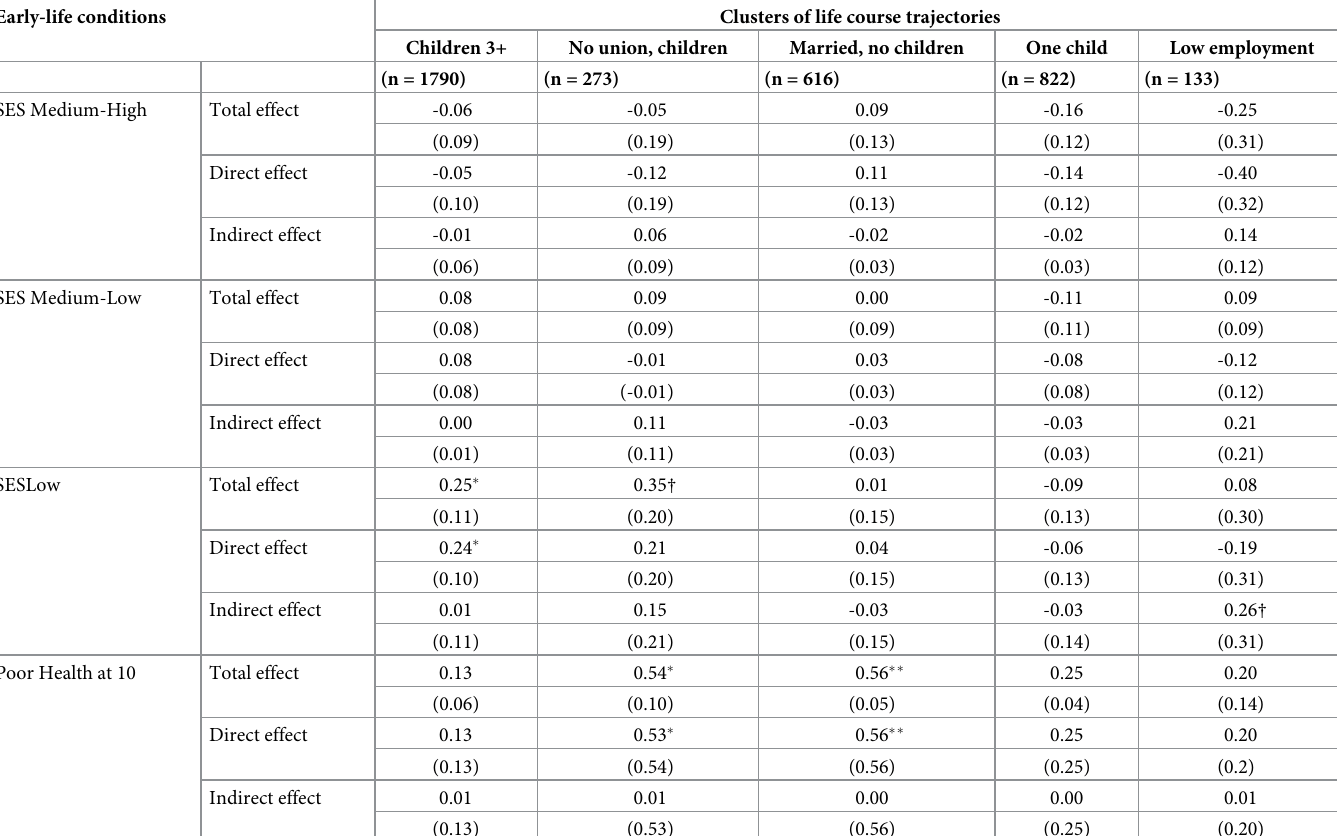
Table 4. Estimated multinomial regression coefficients (standard errors in parentheses) of SES and Health at 10 (early-life conditions) on clusters of life course tra- jectories and mediating effect of education. Men. (N = 5,813). Early-life